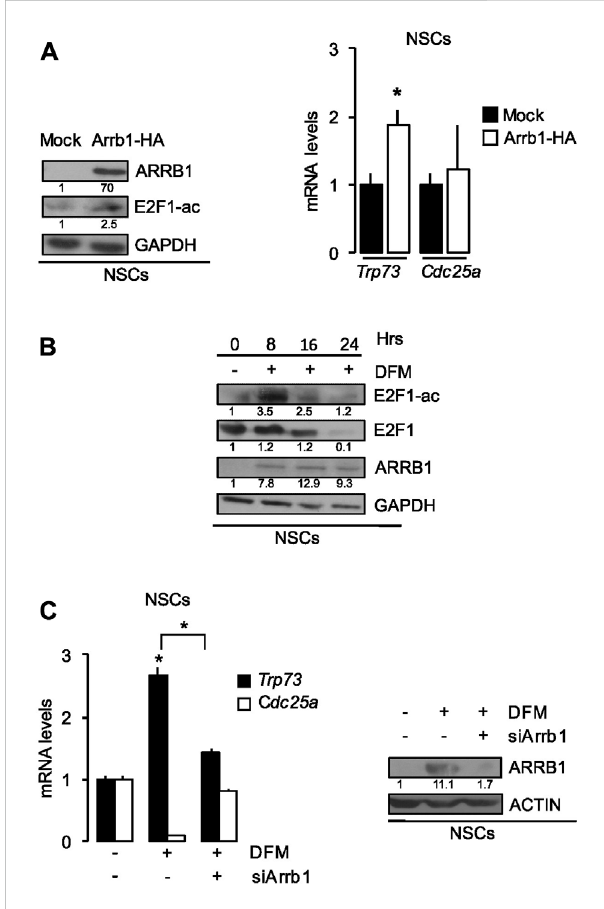
FIGURE 4 ARRB1 controls NSCs apoptosis via E2F1 acetylation. (A) Effects of Arrb1-HA overexpression and mock transfection (control) of NSCs on ARRB1 and E2F1-ac protein levels (Western blot assay-left) and Trp73 and Cdc25a mRNA levels (right). * p < 0.05 vs. mock transfected cells (Mock). GAPDH: loading control for Western blot. (B) Western Blot analysis of endogenous ARRB1, E2F1, and E2F1-ac expression in NSCs cultured in SCM (0 h) and after 8 – 24 h culture in DFM.GAPDH:loadingcontrol.Effectsofsi-Arrb1orscrambledcontrol (siCtr) on (C) Trp73 and Cdc25a mRNA levels (left) and ARRB1 protein levels (Western blot assay-right) in NSCs cultured in SCM (0 h) and after 18 h culture in DFM. ACTIN: loading control for Western blot. For Western blot, densitometry values are shown below the blots and densitometric graphs are presented in Supplementary Figure S2. * p < 0.05 vs. scrambled control